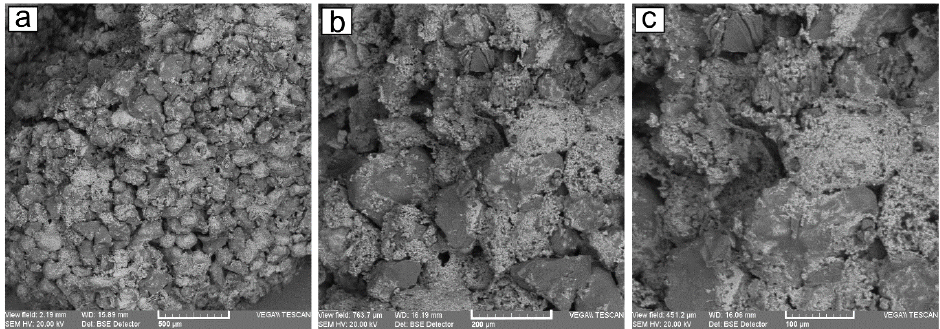
Figure 10. SEM micrographs for the yellow pigment from Siliștea — Pe Cetățuie : ( a ) 100×; ( b ) 300×; ( c ) 500×.